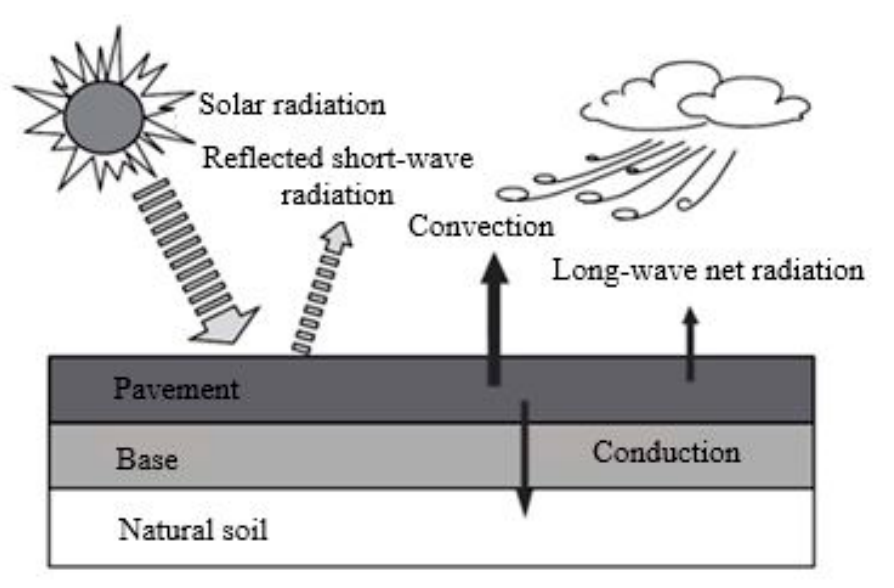
6 on the amount of absorbed and stored solar radiation, released infrared radiation, heat transferred by convection to the air, the heat stored in the mass of material, and heat con- ducted to the ground [57]. Figure 3 illustrates the pavement surface energy balance. The ability of materials to capture heat depends on thermal inertia in addition to other thermal properties. Thermal inertia is related to the ability or material to resist a variation in heat flow or temperature and is defined as the speed at which a material cools or heats up. Thus, inert material is a material that takes a long time to reach a new equi- librium temperature when subjected to a thermal perturbation [58,59]. Table 2. Thermal properties of materials used in building and construction (Modified after Oke) [29]. Material (Dry State) 1220 Urban construction materials have a higher heat capacity and can store more heat than natural materials, such as trees, dry soil, and sand. Urban pavements with low ther- mal conductivity can heat up at the surface but will not transfer heat into the other pave- ment layers as fast as the pavement with higher conductivity. The thermal conductivity of pavement depends on the type of mixture, aggregates used, percentage of each compo- nent in the mixture, and its compaction level. Regarding aggregate base materials or sub-